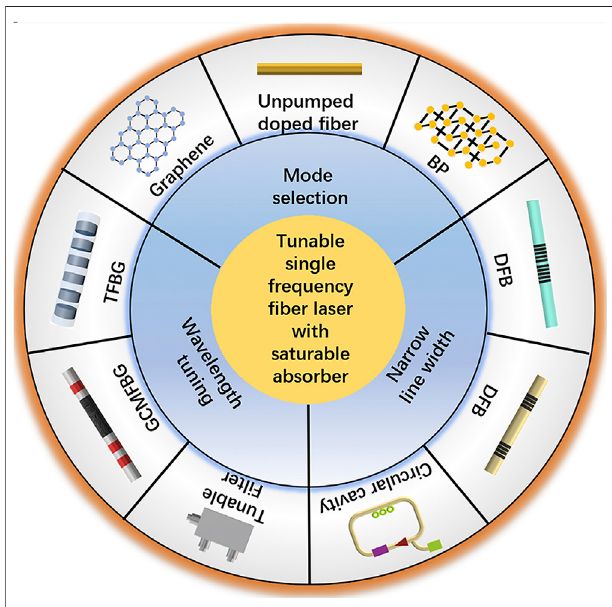
FIGURE10| Themaintechnologyoftunablesinglefrequency fi berlaser.